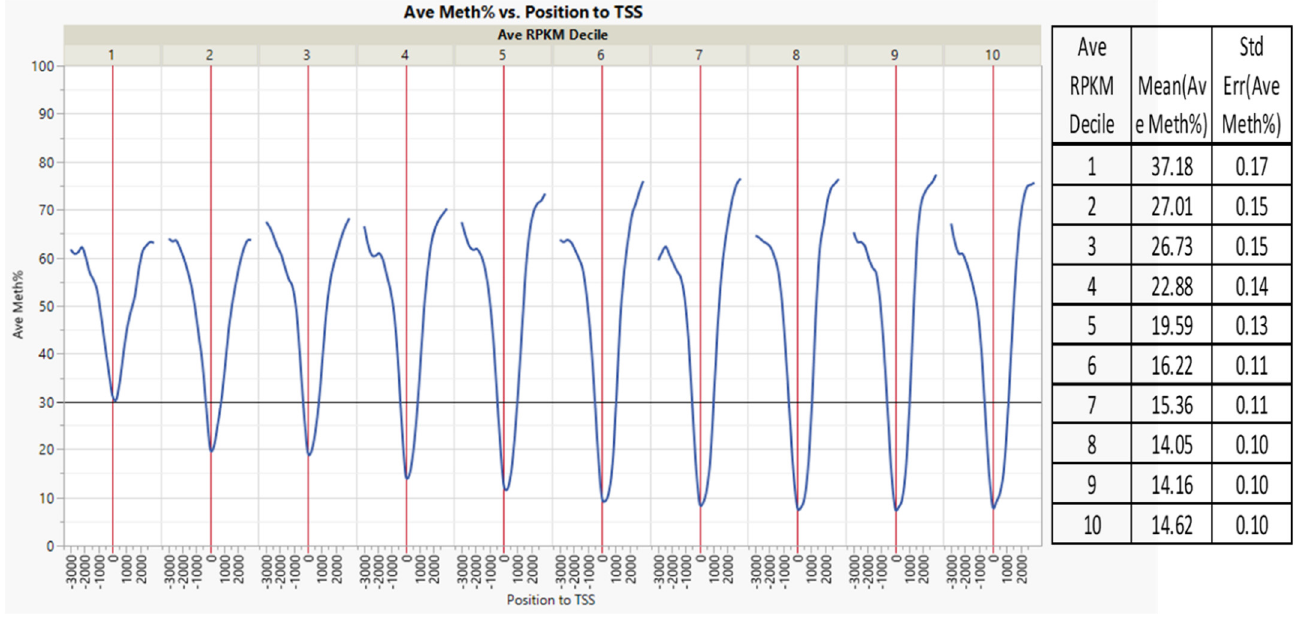
Figure 4. DNA methylation versus gene expression deciles. Inverse relationship between gene expression deciles (based on the increasing ranking of expression measured as RPKM) and gene methylation average percentages of CpGs within ±1 kb of TSS. The table shows the average gene methylation percentages and StdErr for each gene expression decile.